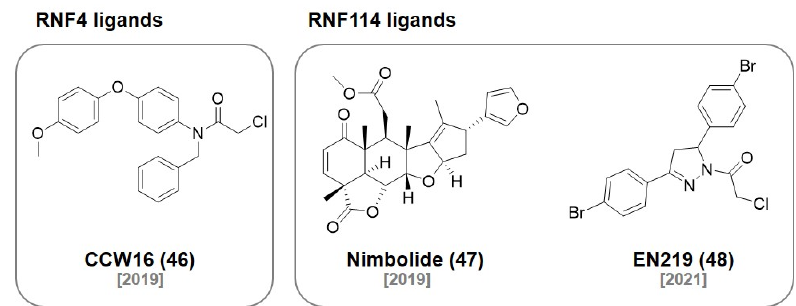
Figure 14. Recent examples of RNF ligands.